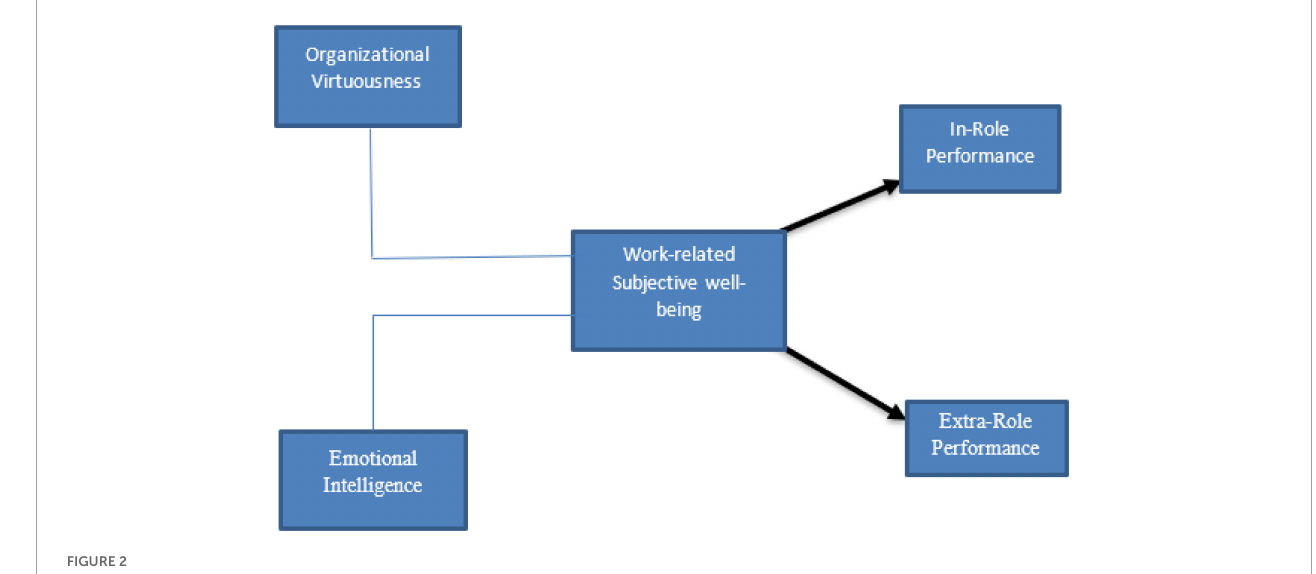
FIGURE2 Research framework.